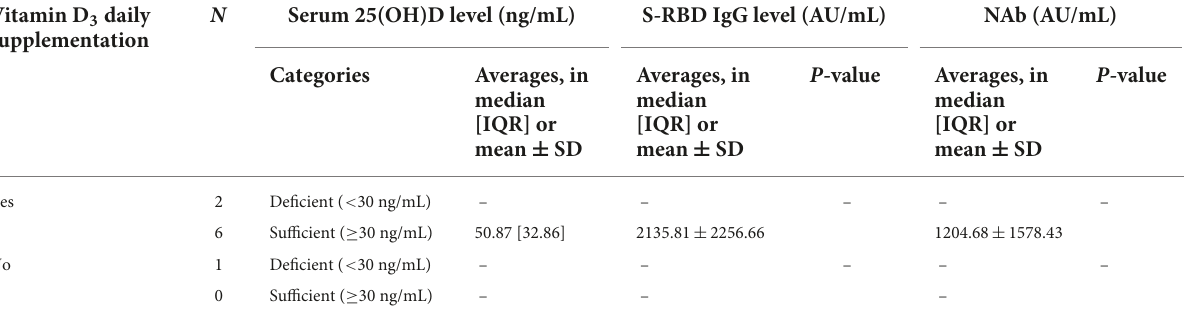
TABLE 5 The comparison between serum 25(OH)D levels and anti-SARS-CoV-2 antibody (anti-SARS-CoV-2 S-RBD IgG and NAb) levels in subjects subgroup by hematologic malignancies. Vitamin D 3 daily